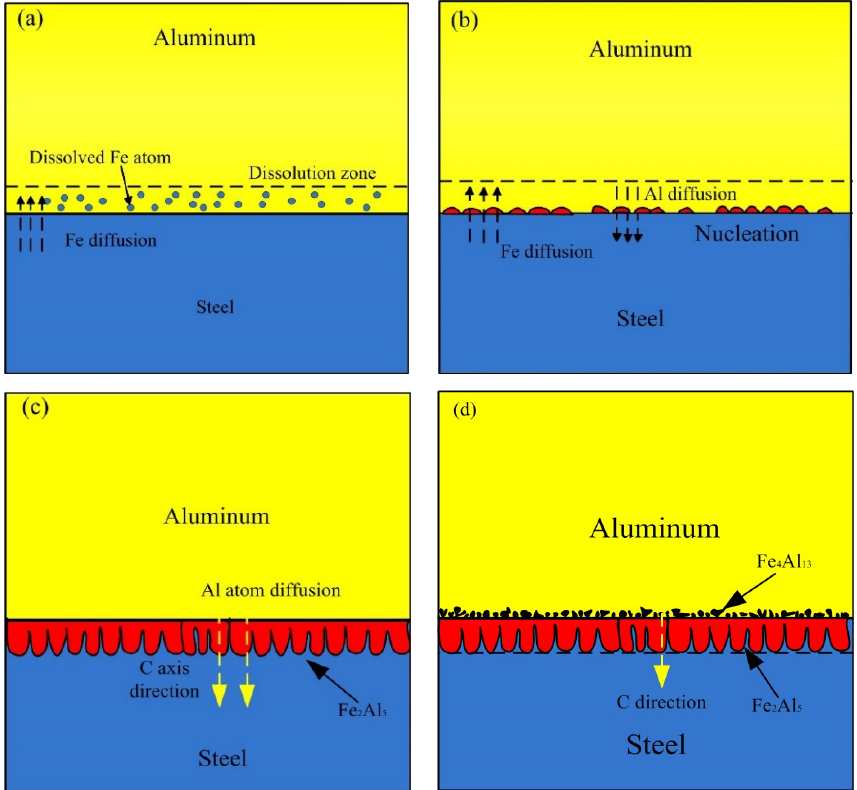
Figure 16. Schematic diagram of the formation and growth of the Al-Fe IMCs layer: ( a ) Fe atoms diffusion process, ( b )nucleation process, ( c ) growth process and ( d ) final process.